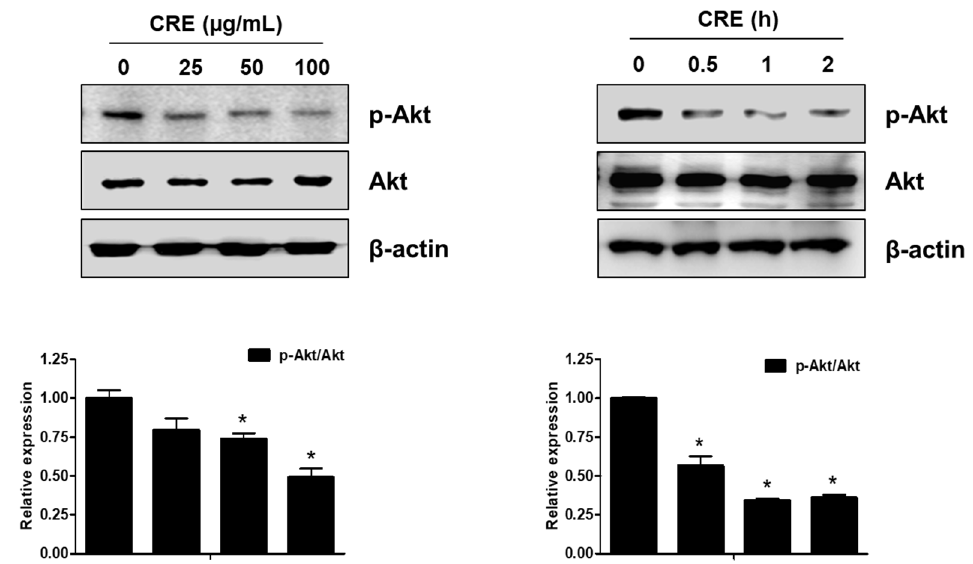
Figure 3. Effect of CRE on the phosphorylation of Akt in endometriotic cells. 12Z cells were treated with CRE (25, 50 and 100 µg/mL) for 2 h or with CRE (100 µg/mL) for 0.5, 1 and 2 h. Phosphorylated Akt and total Akt were measured by western blot analysis using specific antibodies. β -Actin was used as an internal control. Data are shown as mean band density. Data are presented as the means ± SD of three independent experiments; * p < 0.05 as compared with the control group.